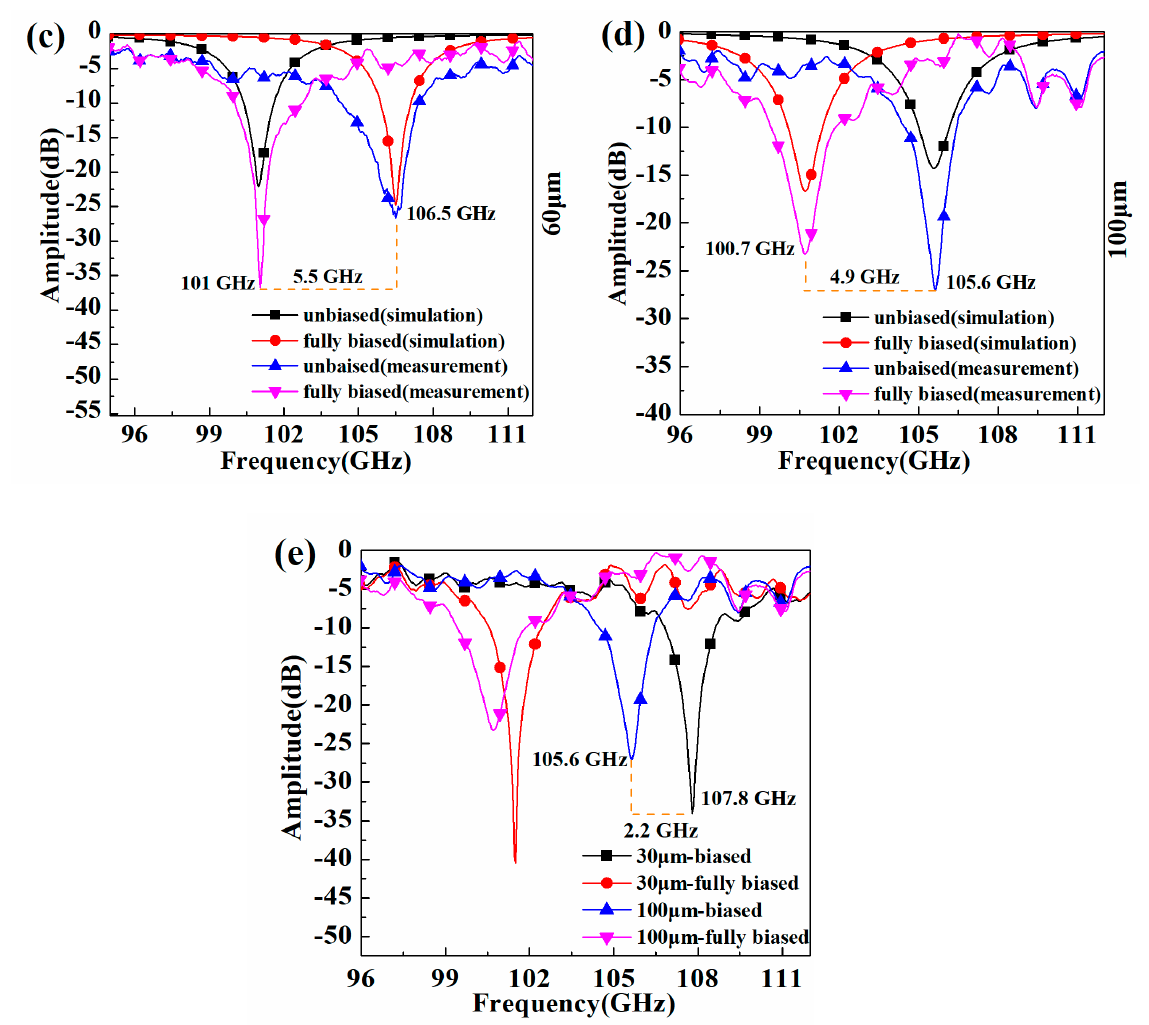
Figure 5. with different thicknesses: ( a ) hlc = 30 µm, ( b ) hlc = 45 µm, ( c ) hlc = 60 µm and ( d ) hlc = 100 µm. ( e ) Measured reflection spectra at 30, 45, 60, and 100 µm.